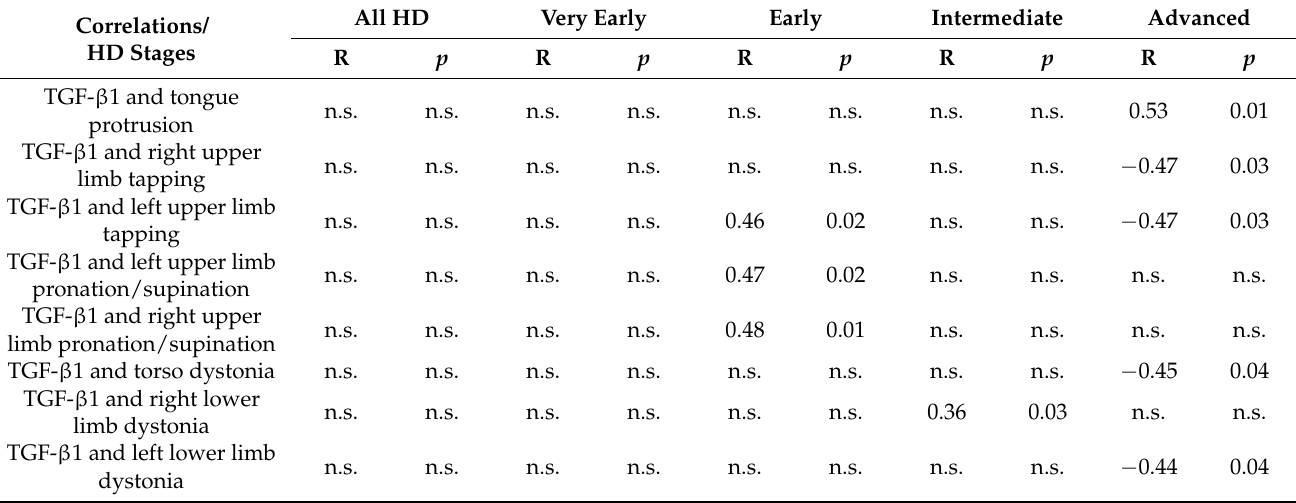
Table 6. Correlations between plasma levels of TGF- β 1 and neuropsychological assessment determined with Spear- man’s test. Correlations/